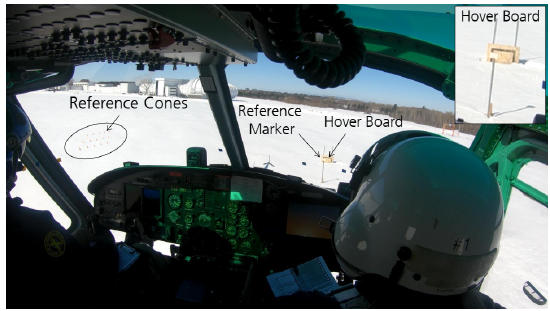
Figure 4. On-board view of elements of ADS-33 Hover test course used for